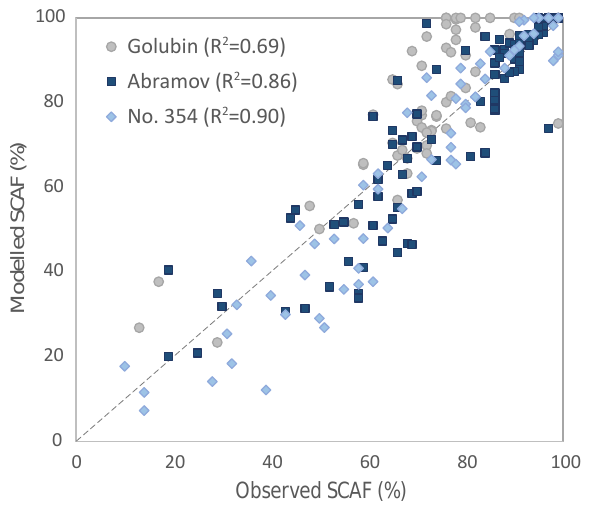
Figure 7. Comparison between observed and modelled SCAF for Abramov, Golubin and Glacier no. 354.